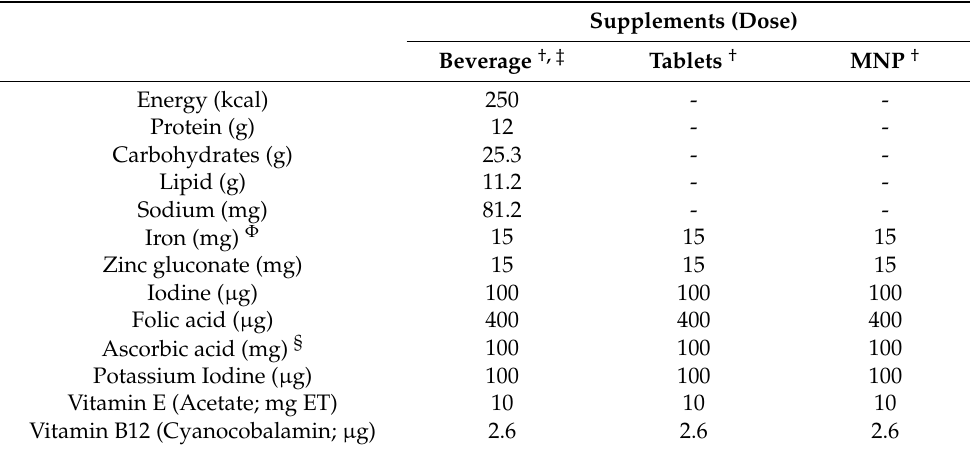
Table 1. Nutritional content of supplements delivered to